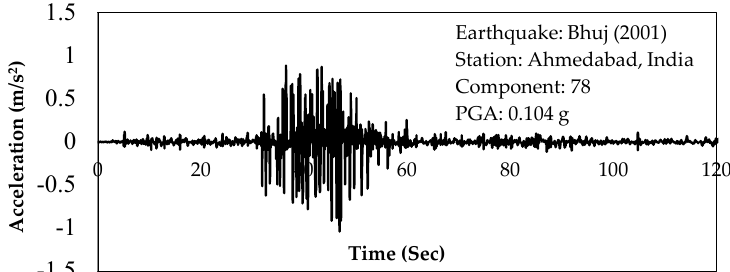
Figure 9. Bhuj (2001) acceleration time history.